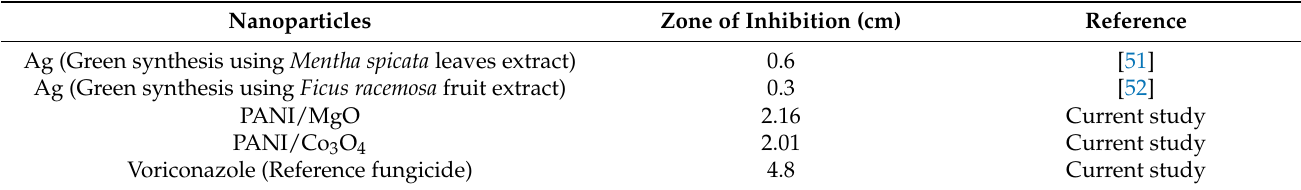
Table 3. Comparison of performance of PANI/MgO and PANI/Co 3 O 4 nanoparticles with reported methods against Aspergillus niger